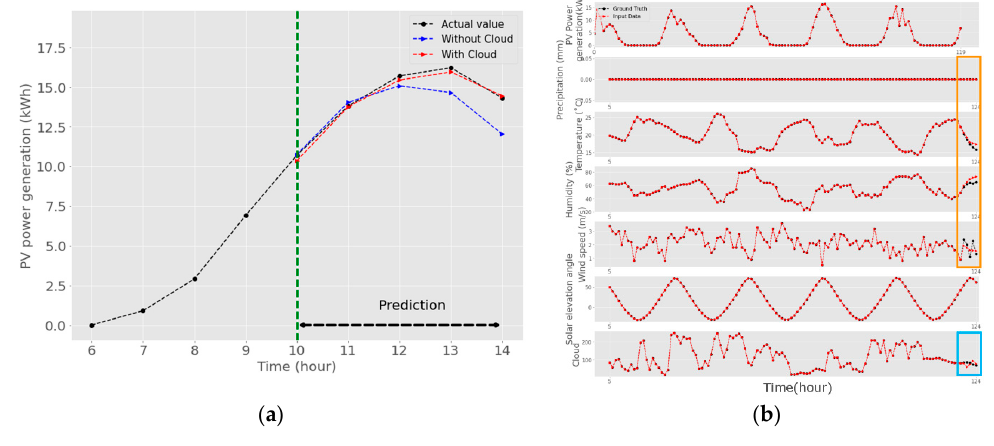
Figure 11. Forecasting on a sunny day.